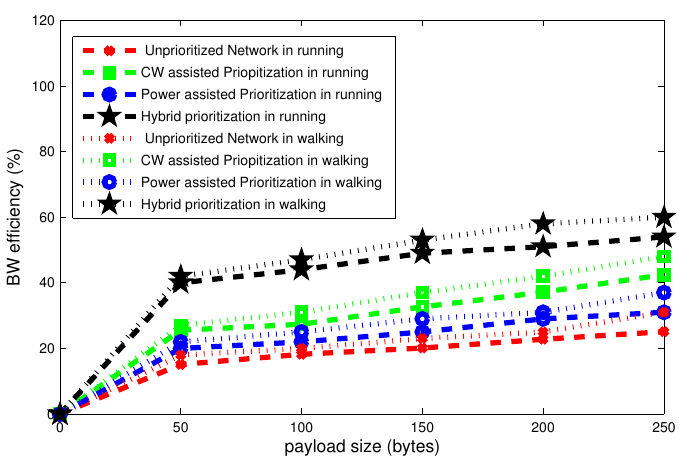
Figure 19. Effect of payload size on bandwidth efficiency in mobile postures.